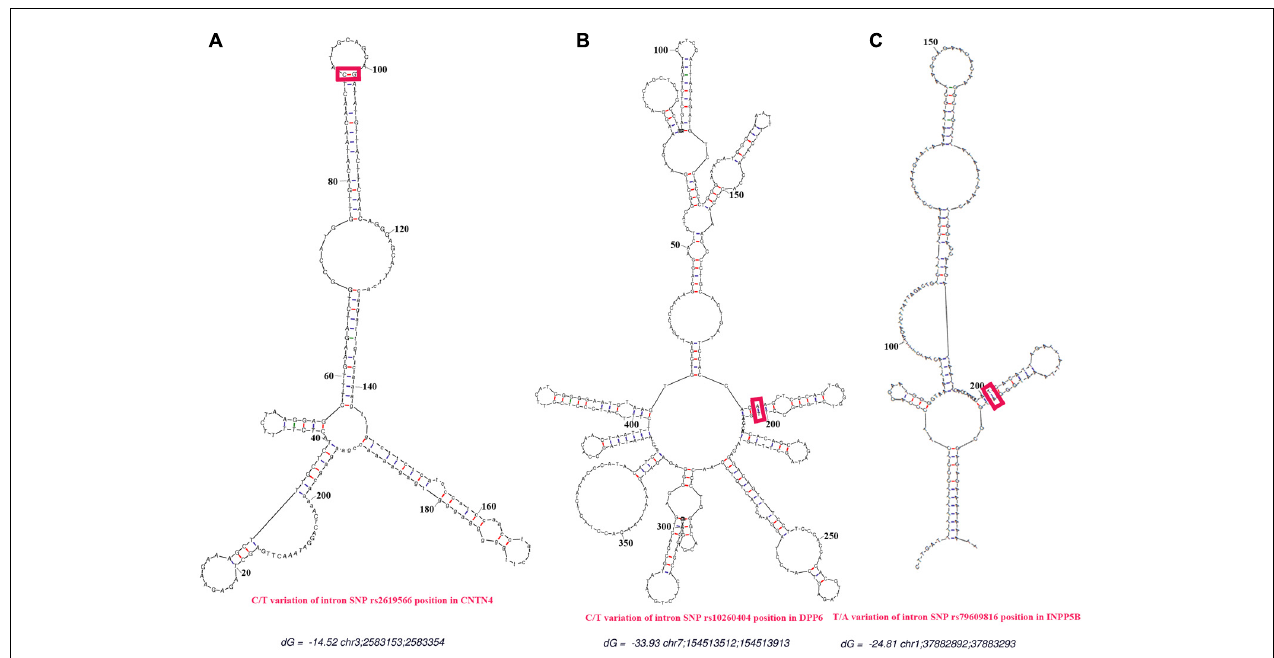
FIGURE 6 | Prediction of secondary structures. The red line represents the predicted binding sites for proteins. The red frames indicate the positions of the SNPs. (A) Secondary structure for the rs2619566 T > C variation in the CNTN4 gene. (B) Secondary structure for the rs10260404 T > C variation in the DPP6 gene. (C) Secondary structure for the rs79609816 A > T variation in the INPP5B gene. All secondary structures of the binding regions in the CNTN4 , DPP6 , and INPP5B genes were predicted as hairpin-like structures.